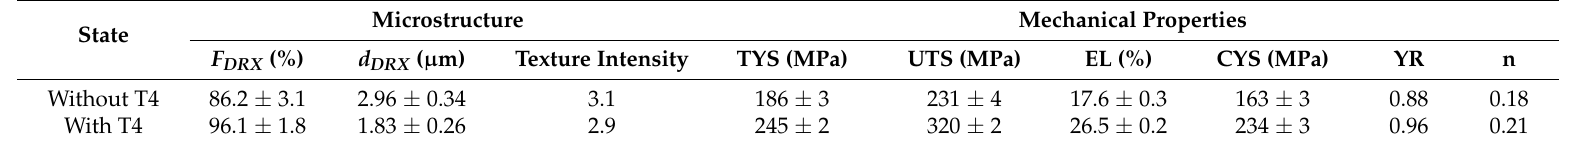
Table 1. Microstructural characteristics and mechanical properties of extruded TZA822